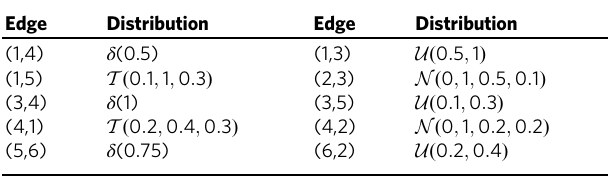
Table 1 The distributions from which the edge weights are drawn for the graph in Fig.